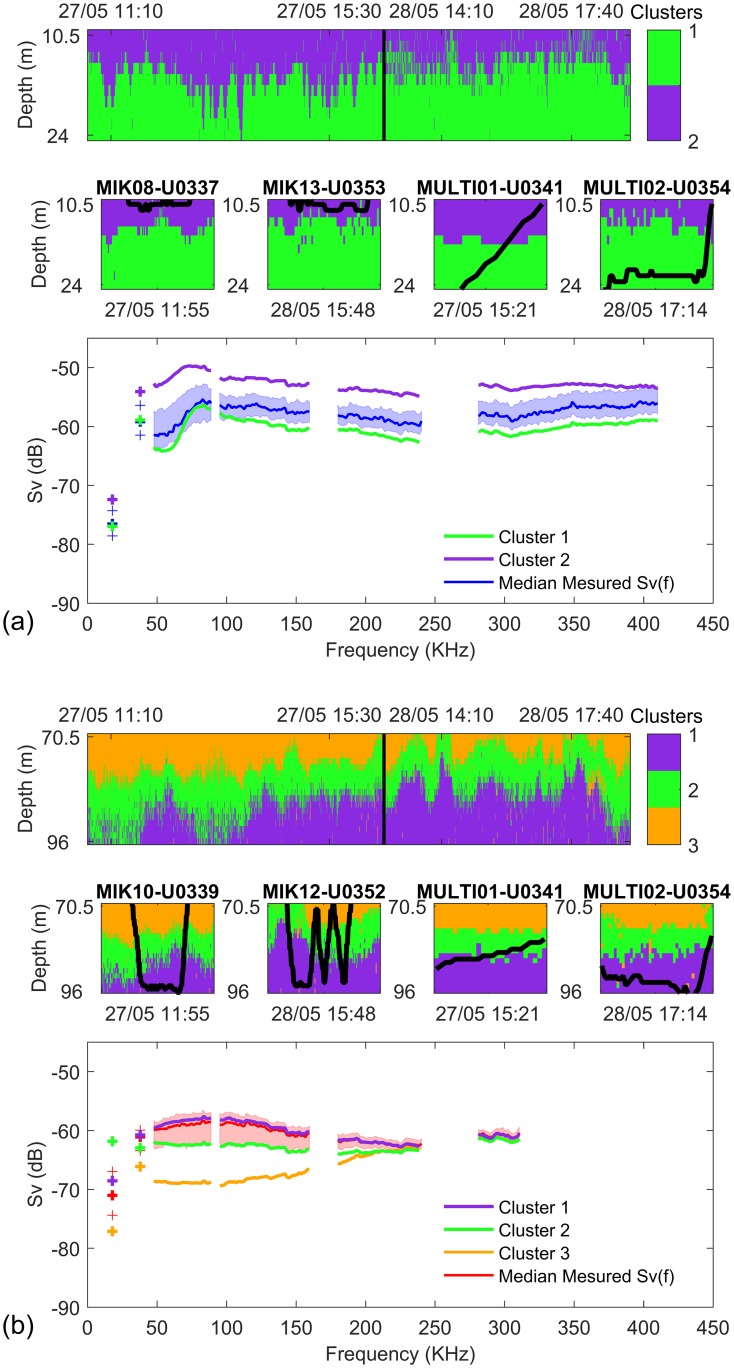
EM clustering results for (a) the surface layer and (b) the deep layer.Upper panels: echo-integration cells belongings to cluster; left of vertical black line: data collected on May, 27th, right of black line: data collected on May, 28th. Middle panel: net trajectories (black lines). Lower panel: median volume backscattering strength spectra at frequency f (Sv(f)) in the whole depth layer (red and blue curve with 25% and 75% quantiles confidence intervals) and in each cluster.